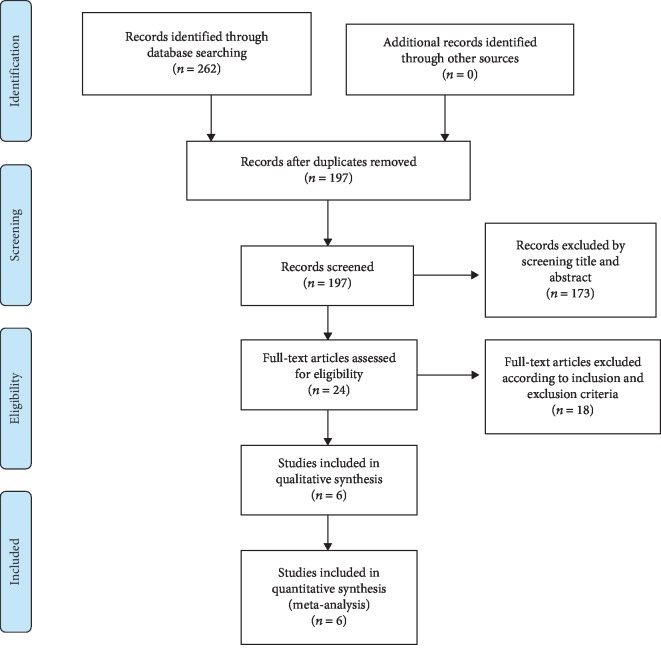
PRISMA flow chart.